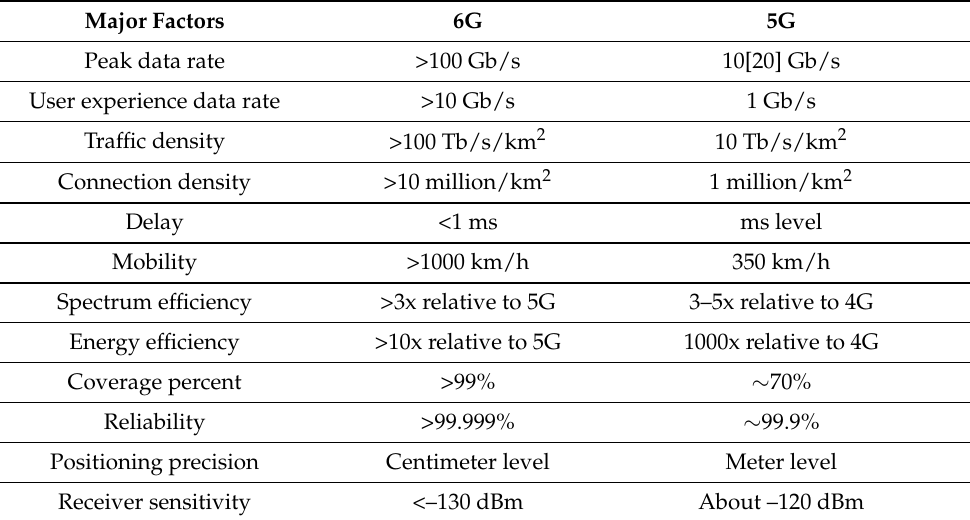
Table 3. The possible capabilities of 6G as opposed to 5G